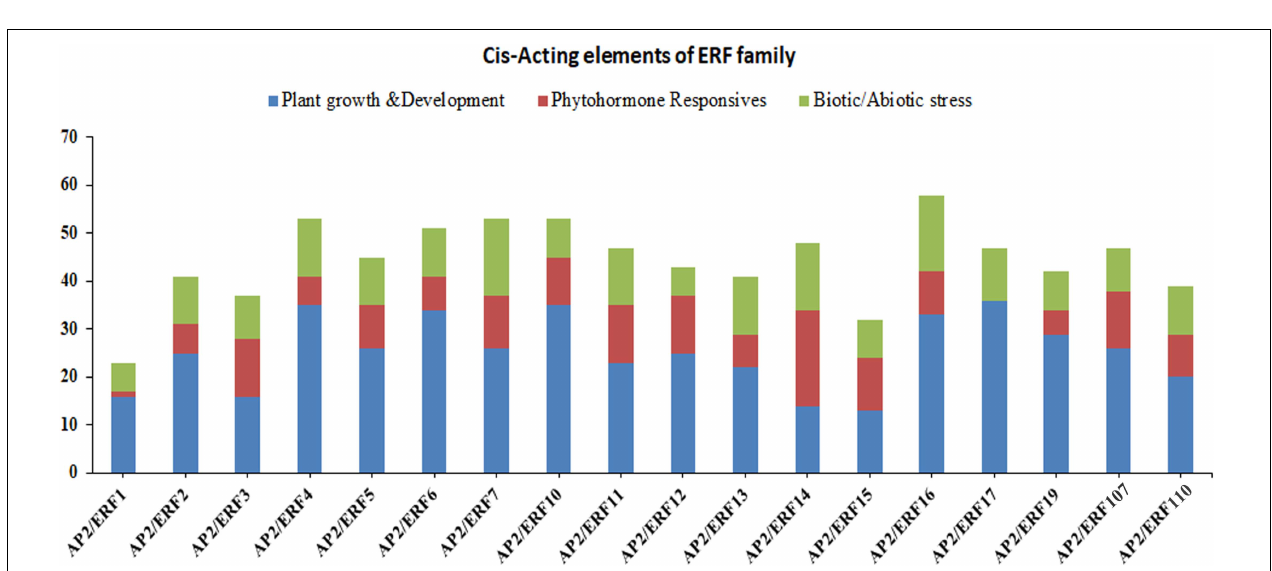
FIGURE 3 | Investigation of cis -acting element numbers of TaAP2/ERF genes in Wheat. Cis- acting elements of each category represented by different colors.